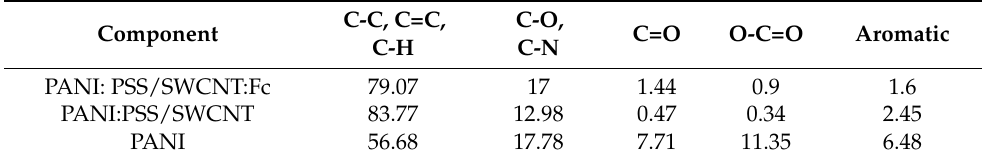
Figure 6. Spectra deconvolution of electrons from 1s orbital carbon C1s for ( a ) PANI; ( b ) PANI:PSS/SWCNT; ( c ) PANI:PSS/ Figure 6 SWCNT/Fc; spectra deconvolution of of electrons from 1s orbital of oxygen, O1s for ( d ) PANI; ( e ) PANI:PSS/SWCNT; ( f ) PANI:PSS/SWCNT/Fc; spectra deconvolution of electrons from 1s orbital of nitrogen, N1s for ( g ) PANI; ( h ) PANI:PSS/SWCNT; ( i ) PANI:PSS/SWCNT/Fc; spectra deconvolution of of electrons from 2p orbital of iron, Fe 2p for ( j ) PANI:PSS/SWCNT/Fc. Table 1. The component for C1s